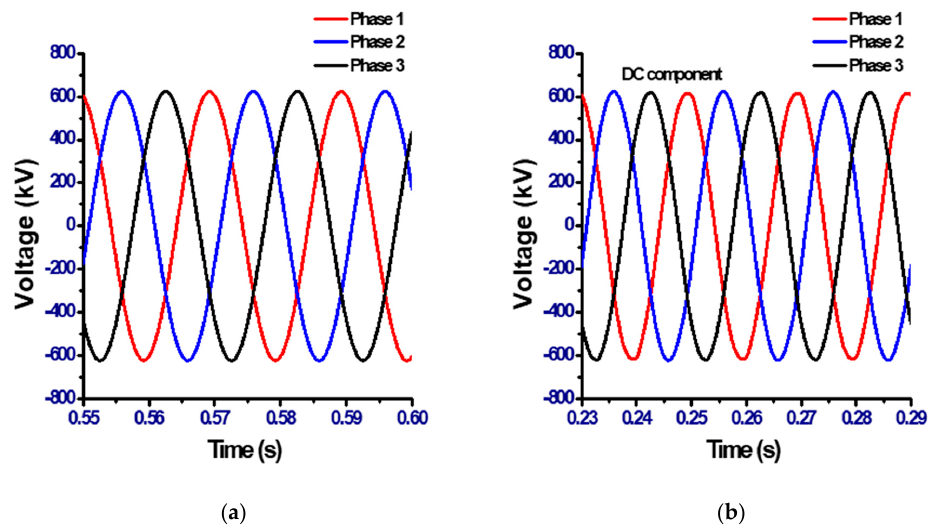
Figure 8. Results of ( a ) arm voltages-direct modulation and ( b ) arm voltages-proposed direct modulation.